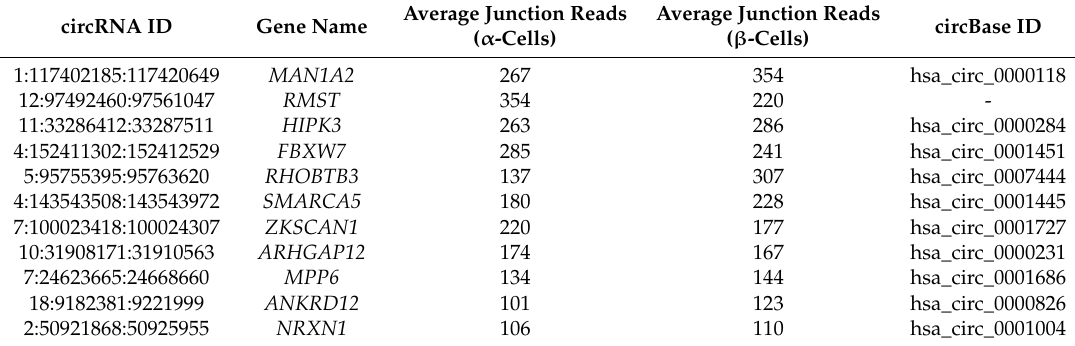
Table 2. Highly expressed circRNAs in α - and β -cells. The highly expressed candidates with an average of >100 junction spanning reads in α - and β -cells are listed along with their annotations and expression